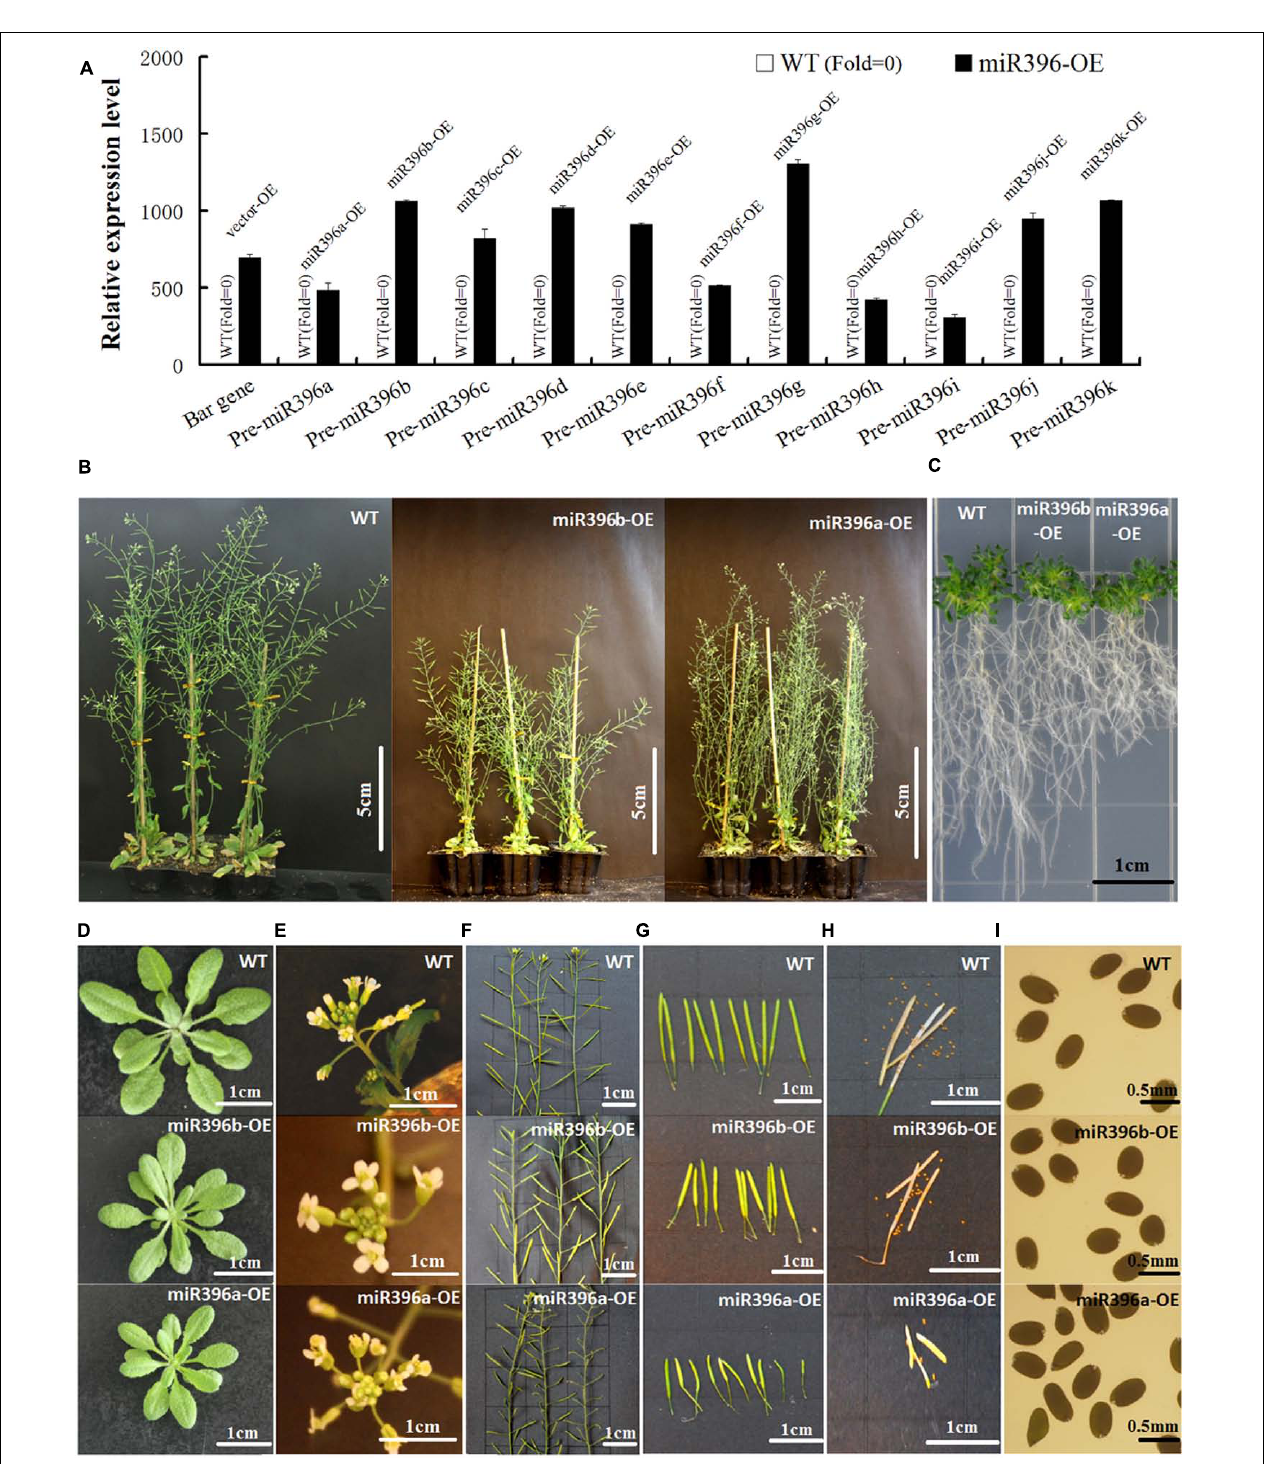
FIGURE 4 | Over-expressing Pre-miR396a/b/c/e/h/i/k in Arabidopsis affected tissue development of transgenic plants. (A) The expression analysis of bar gene in vector-OE and Pre-miR396a-k in miR396(a-k)-OE. WT was used as control, Actin (AT3G46520) was used as reference gene. (B) Adult plants; (C) Roots on MS + 3% sugars + 0.8% agar; (D) Rosette of 30-day-old Arabidopsis ; (E) Inflorescence; (F) Stem with siliques; (G) Siliques; (H) Seeds in one silique; (I) Seeds. Compared with WT/vector-OE, miR396a/b/c/e/h/i/k-OE were dwarfed, with short roots, small leaves, and smaller and fewer silique. Only miR396a/i-OE exhibited abnormal silique and flowers. As all miR396a/b/c/e/h/i/k-OE transgenic Arabidopsis exhibited similar morphological phenotype, only the WT and miR396a/b-OE plants were shown as representative plants. In addition, miR396d/f/g/j-OE did not display any changes.